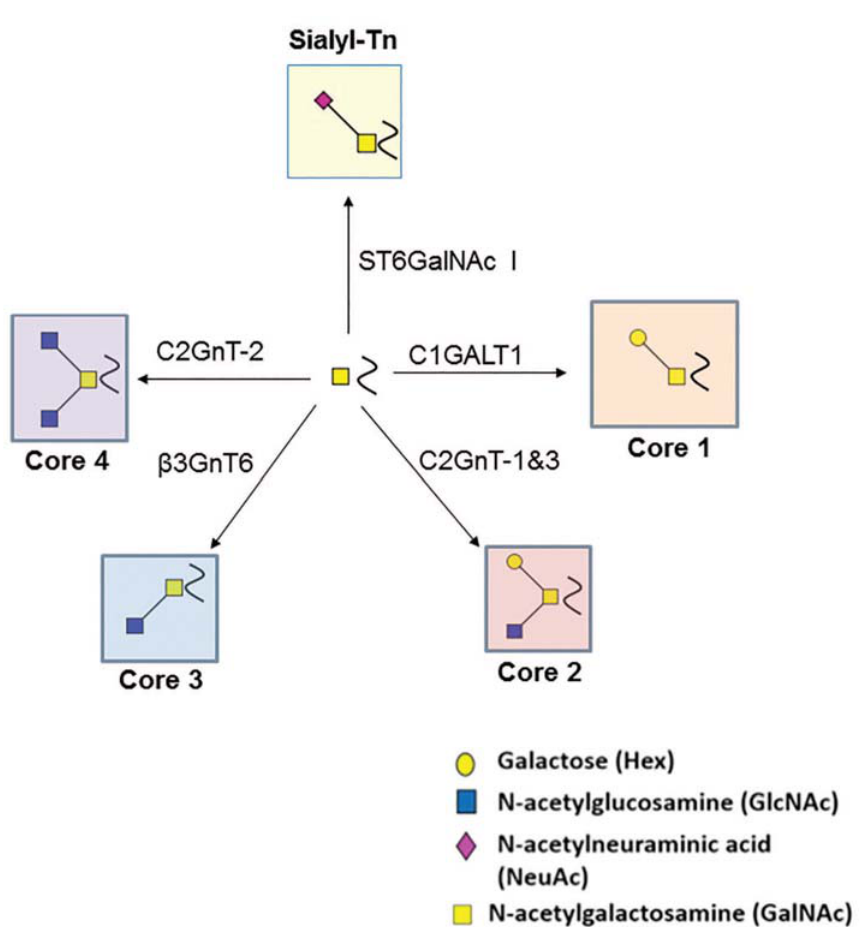
Figure 1. This schematic represents an extension of the O ‐ linked glycans by different initiating and truncating enzymes. Herein, C1GALT1 which is a Core ‐ 1 synthase results in the formation of Gal β 1,3GalNAc glycan by transferring Galactose from UDP ‐ Gal to GalNAc. Once this enzyme adds galactose, then the substrate becomes favorable for Core ‐ 2 formation via C2GnT. This enzyme forms GlcNAc β 1,6(Gal β 1,3)GalNAc by transferring GlcNAc (N ‐ acetylglucosamine) from UDP ‐ GlcNAc onto Gal β 1,3GalNAc. C1GALT1 competes with ST6GalNAc ‐ I for the addition of Neu5Ac (sialic acid) from CMP ‐ Neu5Ac onto GalNAc. Lastly, C1GALT1 competes with B3GNT6 to form Core ‐ 3 structure by adding GlcNAc in a β 1,3 linkage onto GalNAc. This enzyme is followed by C2GnT that adds GlcNAc in a β 1,6 linkage onto GlcNAc β 1,3GalNAc forming trisaccharide Core ‐ 4 structure.